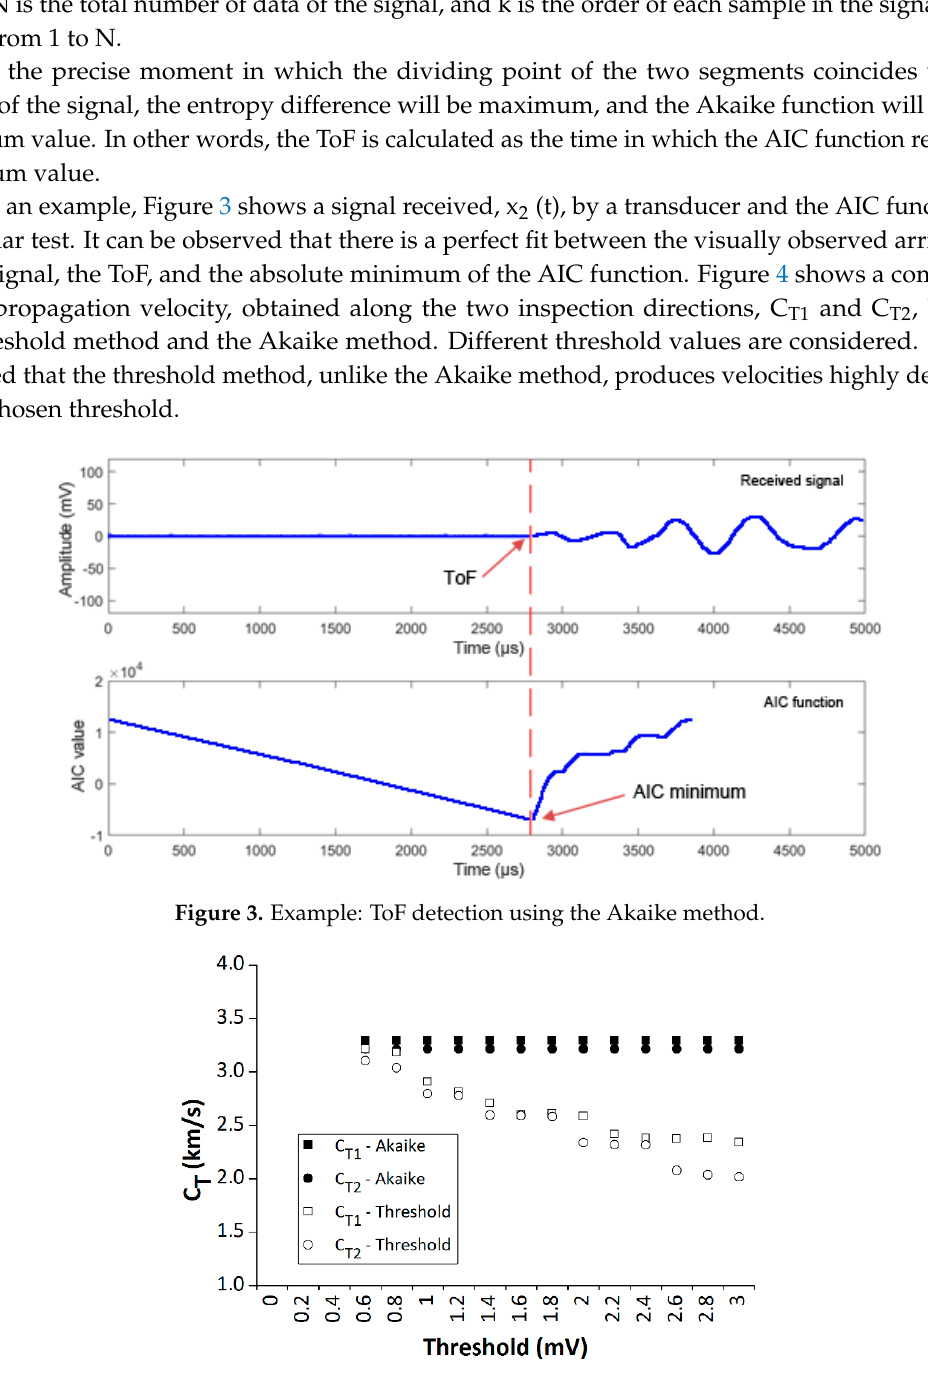
Figure 4. Propagation velocity as a function of the selected threshold. Comparison between the threshold and Akaike methods.